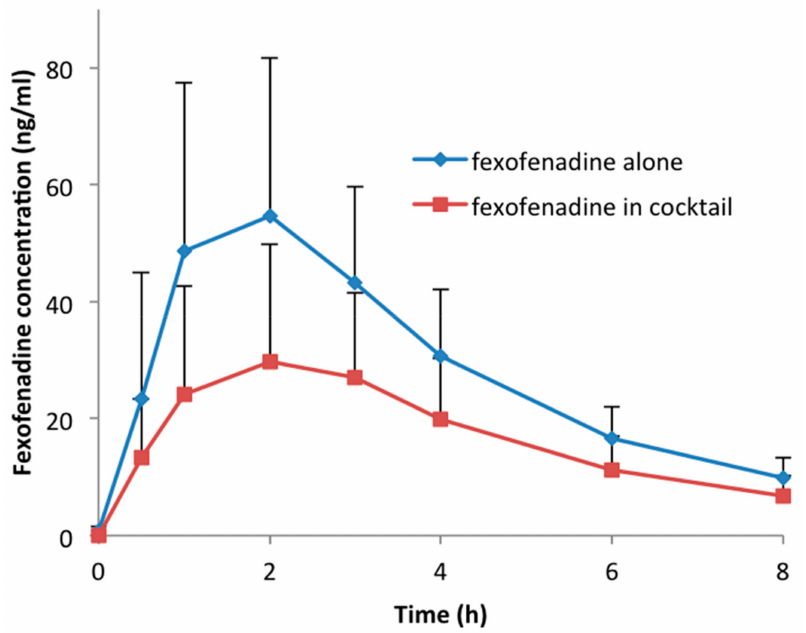
Figure 1. Concentration–time profile of fexofenadine administered alone or within cocktail.